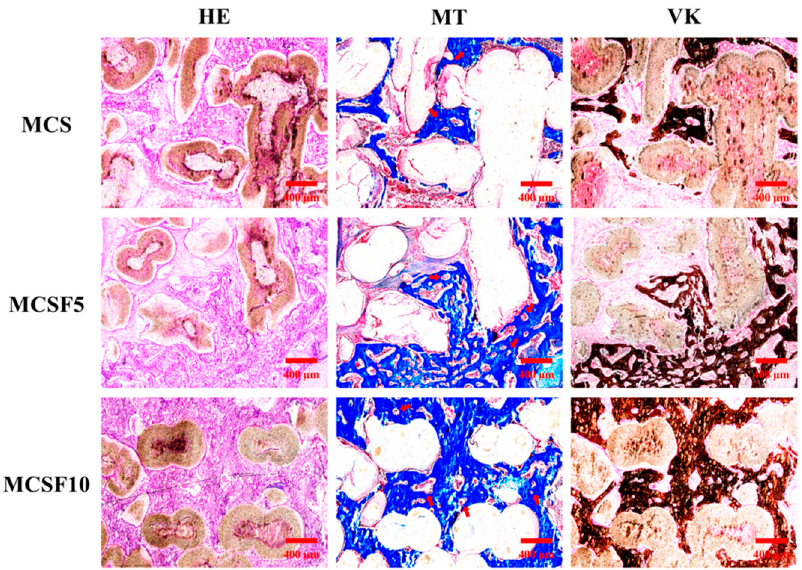
Figure 9. Hematoxylin and eosin (HE), Masson’s trichrome, and von Kossa staining of the femur defects after implantation with different 3D printed scaffolds for 4 weeks. Red arrows indicate the neovascular lumens.